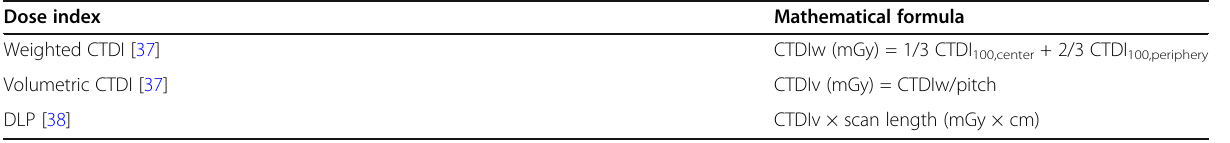
Table 2 Common CT dose